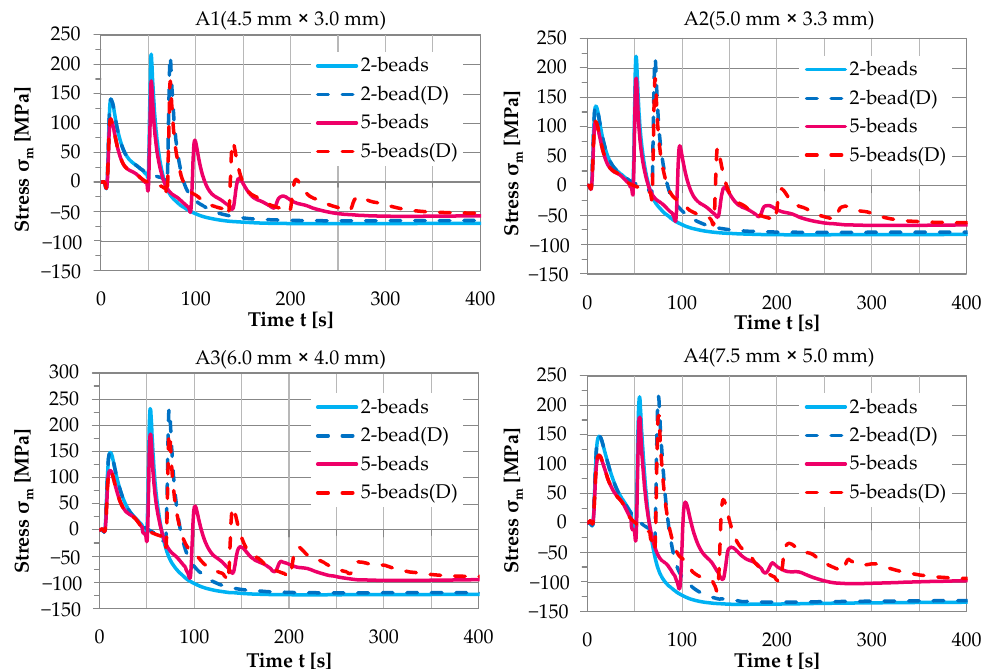
Figure 24. Comparison of stress history of the tool elements with 2 and 5 parallel beads of dimensions (A1–A4), welded with delay (D = 20 s) and without time delay between the beads.